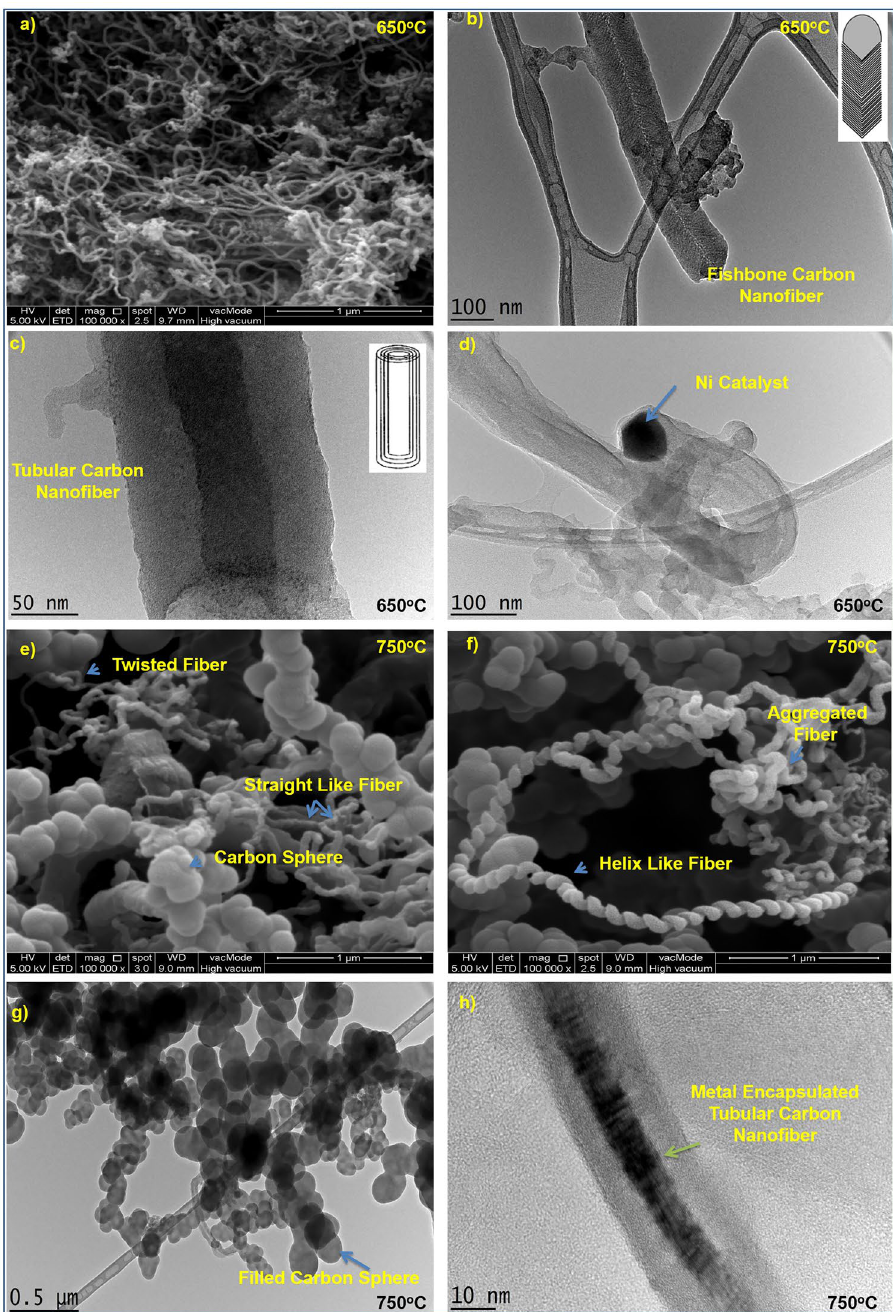
Figure 5. FE-SEM image of CNF ( a ) cum TEM images of CNF ( b – d ) obtained at 650 °C; and FE-SEM images of CNF, helix and CS ( e , f ) cum TEM images of CS ( g ) and of metal encapsulated CNF ( h ) produced at 750